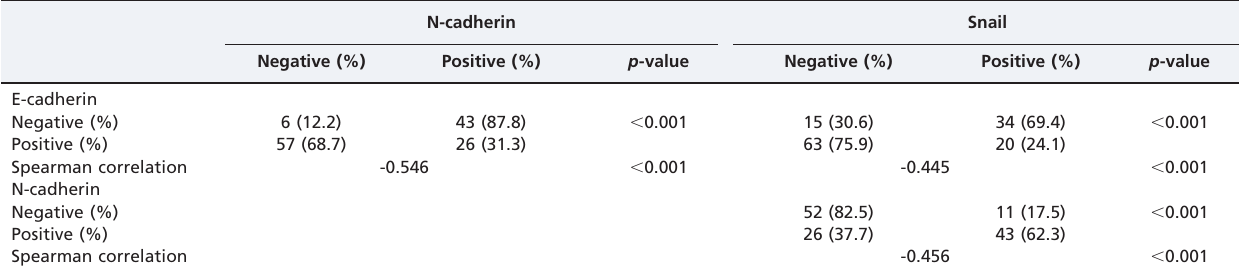
Table 3 - Relationship among E-cadherin, N-cadherin and Snail expression in ductal breast carcinoma. N-cadherin